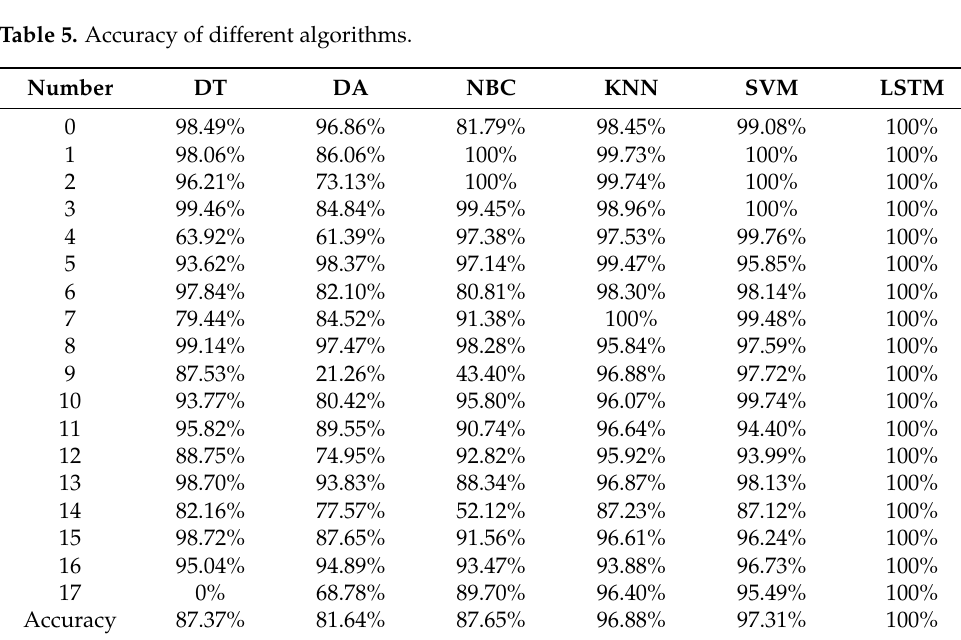
Figure 14. Training loss value and accuracy of LSTM algorithm.